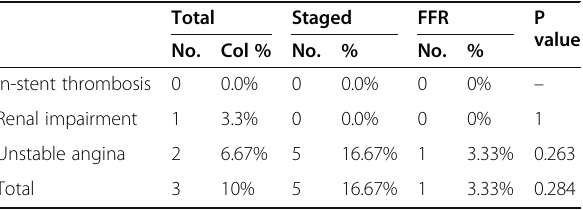
Table 3 Short-term complications. There was only one patient who suffered renal impairment from the total group. Also, there were 5 patients (16.67%) from the staged group who experienced anginal pain during the hospital stay that was compared to 2 patients in the total group and only one patient in the FFR group Total Staged FFR P value No. Col % No. % No. % In-stent thrombosis